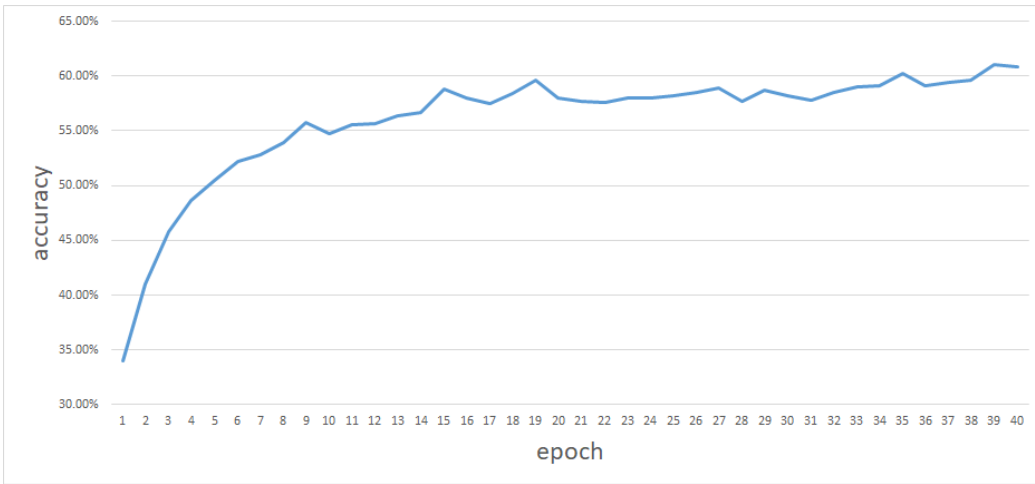
Figure 9. The accuracy changes with epochs.